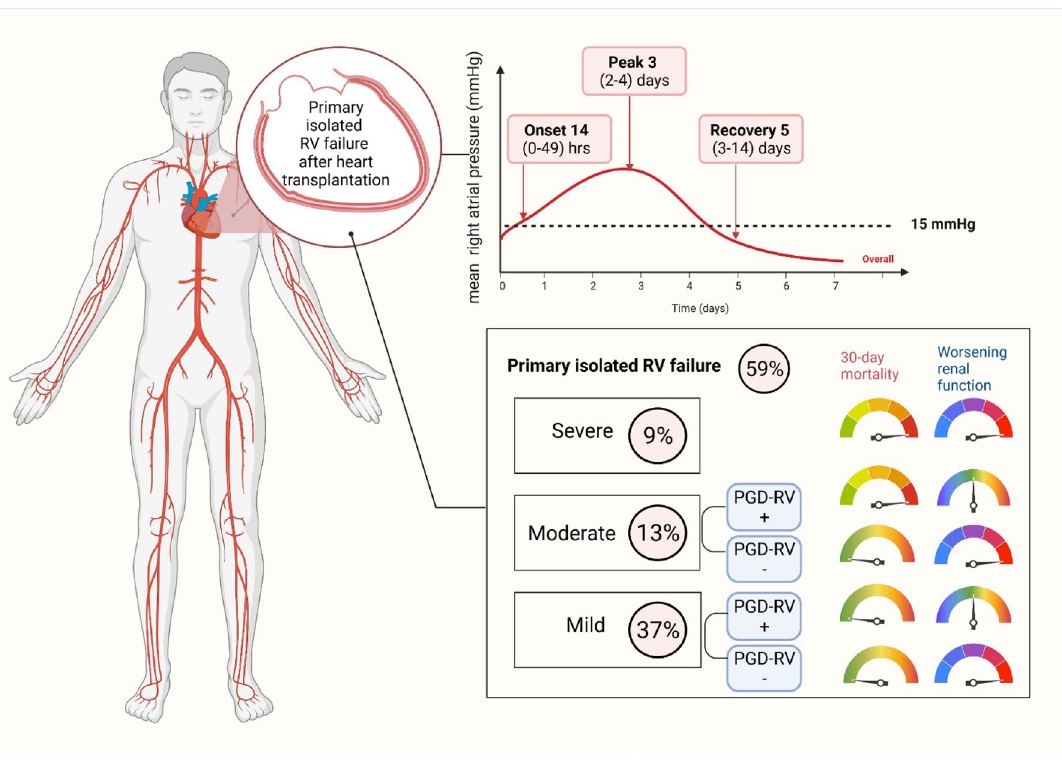
Figure 5. Central